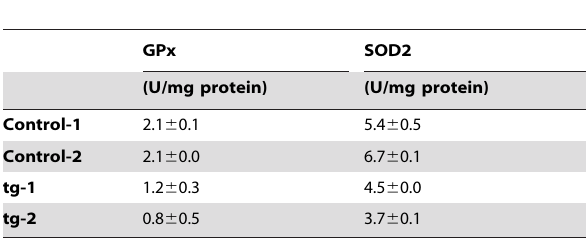
Table 2. Enzyme activities of GPx and SOD2 in the liver of control and HBV transgenic mice intravenously injected with anti-Fas antibody